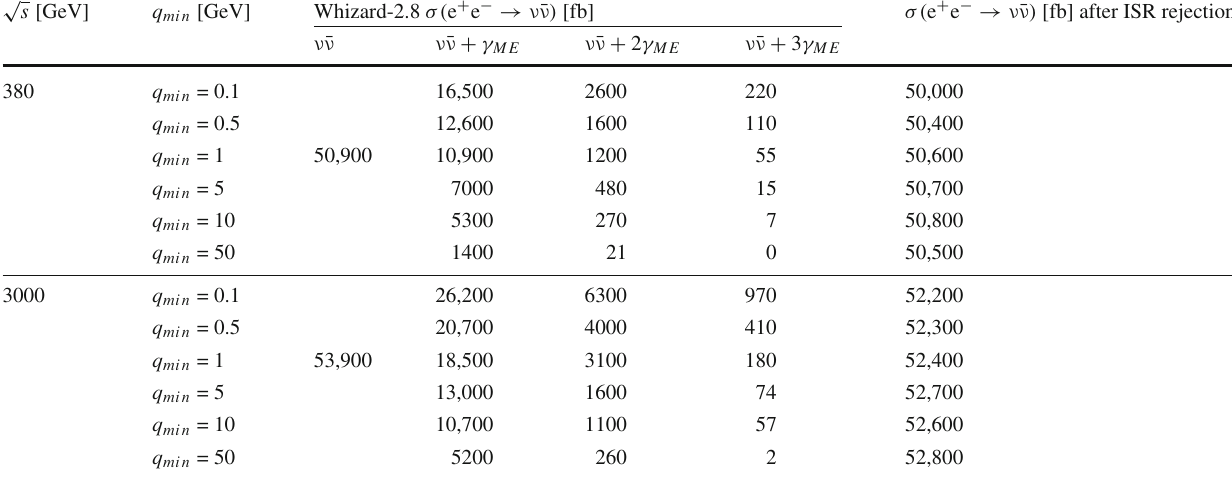
Table 2 Cross section values for different merging parameter q min in (radiative) ν ¯ ν events for different multiplicities of photons included in the matrix element calculations. Number of significant digits indicates the statistical precision resulting from Whizard integration